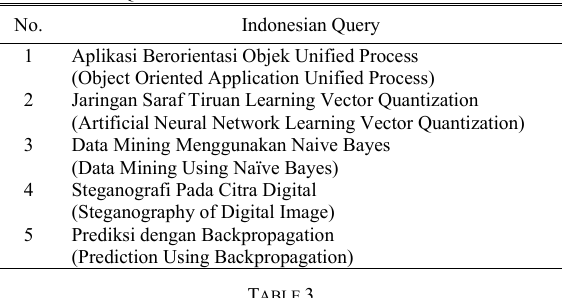
TABLE 2 Q UERY F OR T HESIS A BSTRACT D